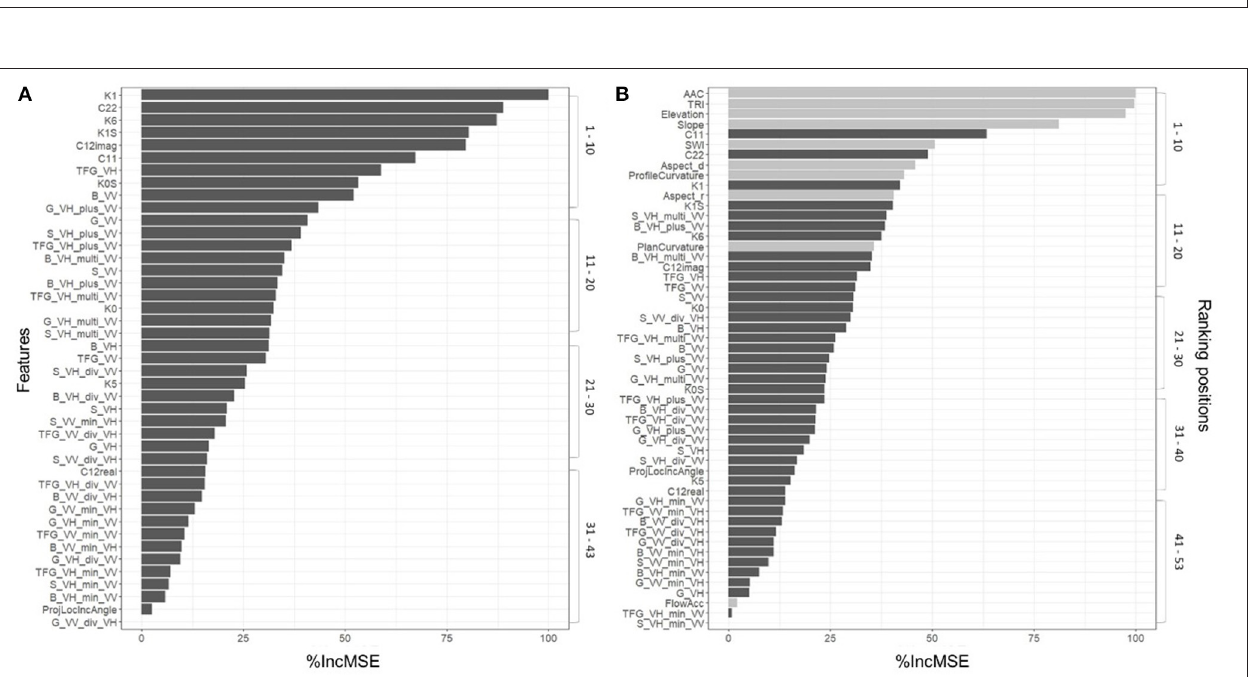
FIGURE 6 | Importance of SAR (dark gray) and terrain (light gray) parameters in the ensemble models built from (A) 43 SAR parameters for θ NovSAR and (B) 53 SAR and terrain parameters for θ NovSAR + Terrain .